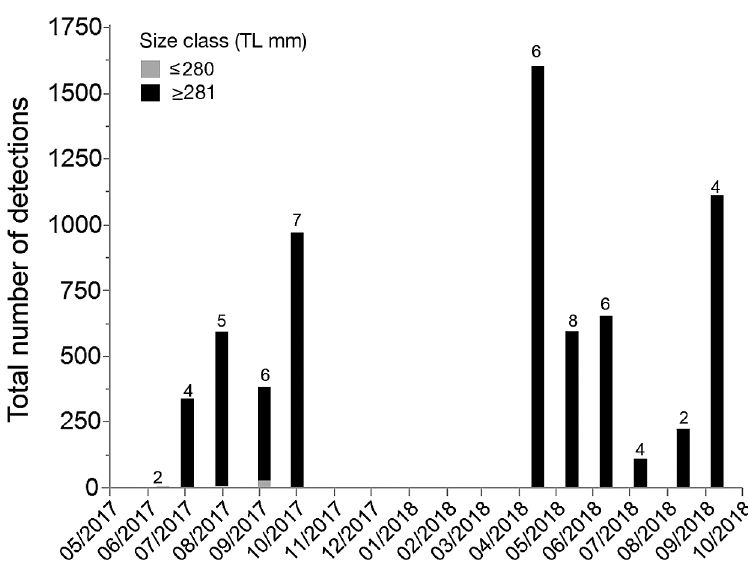
Fig. 6. Total number of seabream detections and number of seabream (number above the bar) recorded by the acoustic receiver by size class (≤280 and ≥281 mm TL) during monthly predation tests at the experimental platform (May 2017 to October